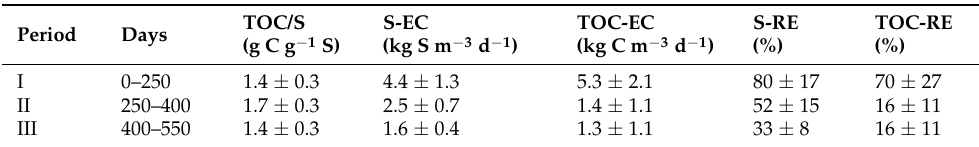
Table 2. Removal efficiencies and elimination capacities were obtained along with the UASB oper- ation.